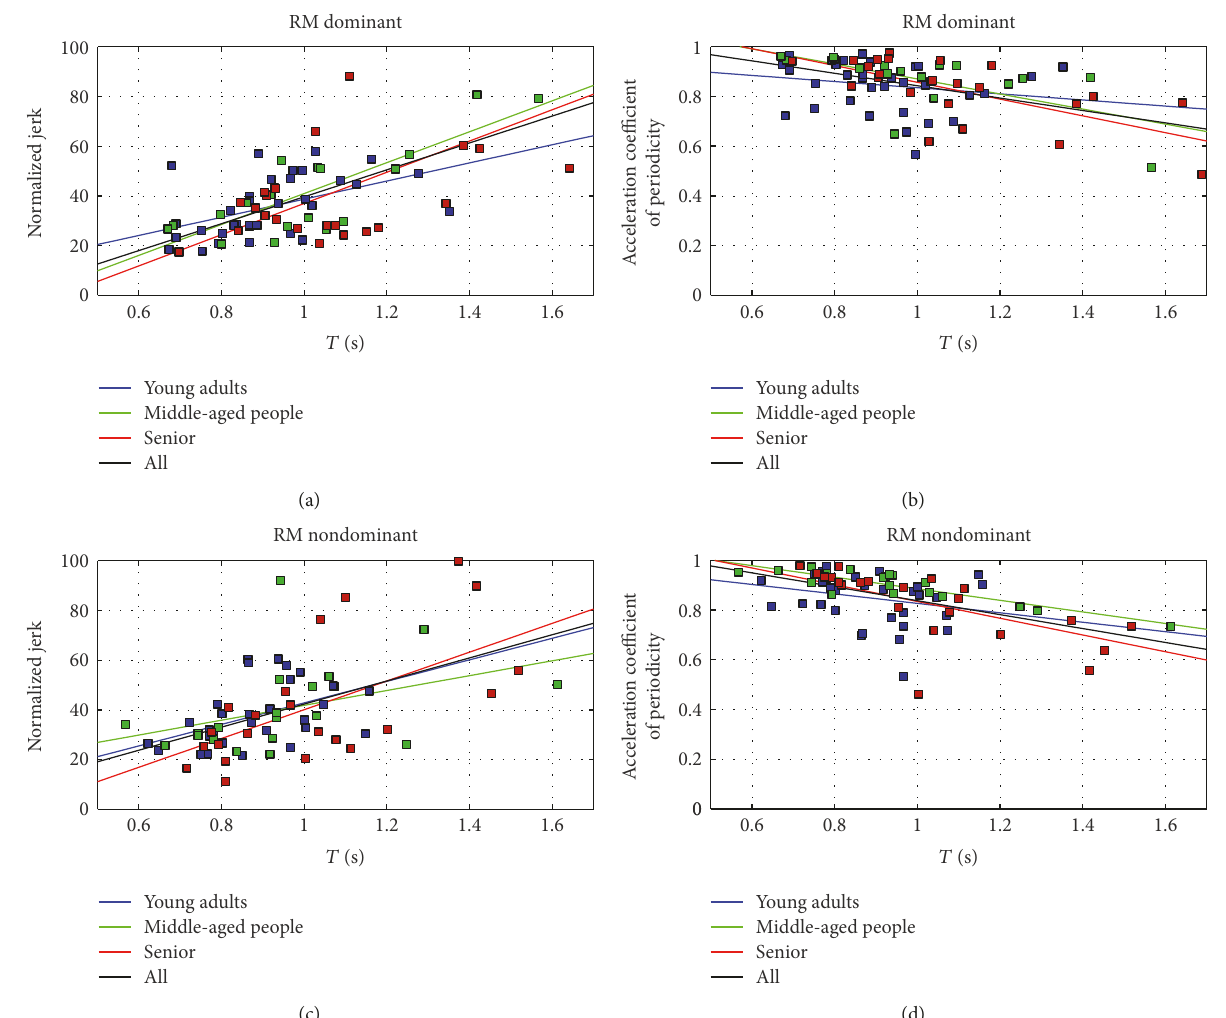
Figure 4: RM: regression curves for normalized jerk and acceleration coe ffi cient of periodicity for age